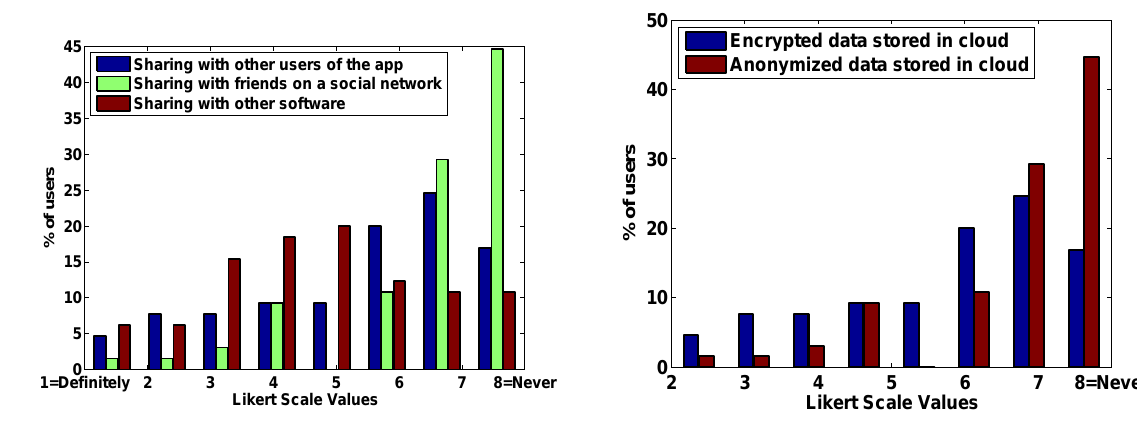
Figure 2. Responses to Data sharing and Data Storage and Retention Questions (best viewed in